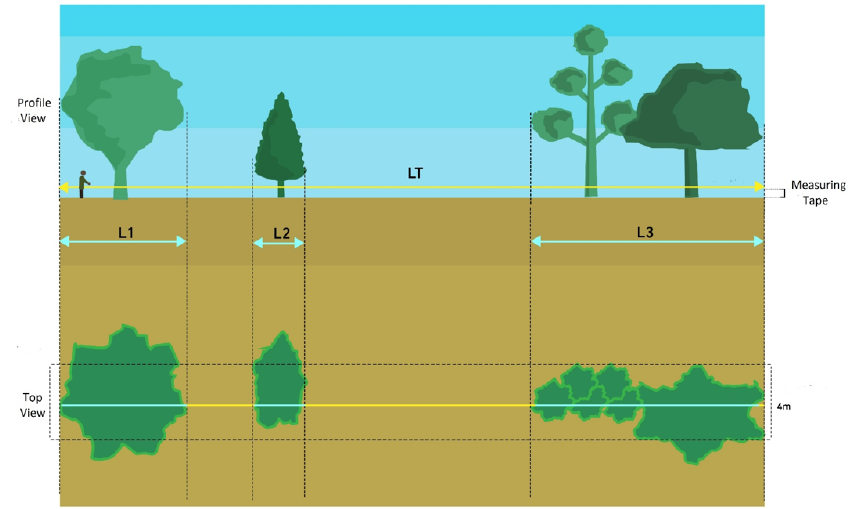
Figure A1. Vegetation Cover measuring procedure on a 25 × 4 m plot, where LT is Linear Totality. In the fieldwork procedures, LT is equal to 25 m, and the field plot is defined by considering 2 m from each LT perpendicular direction, forming then a 25 × 4 m plot. L1, L2, and L3 are examples of linear measurements in LT that are covered by trees. Thus, Vegetation Cover is the sum of L1, L2, and L3 divided by LT. Source: adapted from INEA